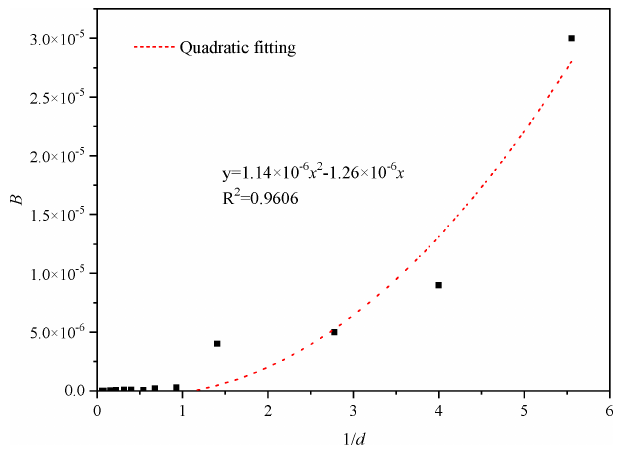
Figure 14. Variation of B with 1 /d for different homogeneous par- ticle